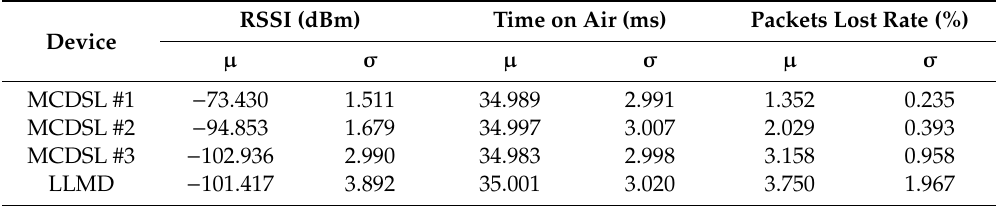
Table 8. Transmission statistics.